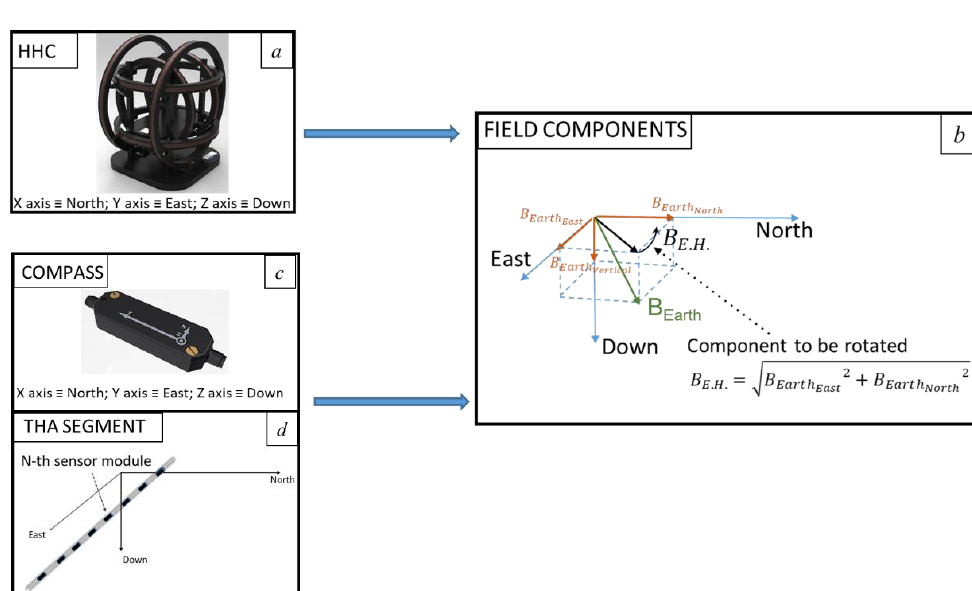
Figure 2. Set-up alignments procedure. ( a ) The HHC produces the field components. ( b ) Definition of the field components in a NED (East, North, Down) reference frame. ( c , d ) The THA segment and the compass are subject to the field components. Drawing and pictures are not to scale.